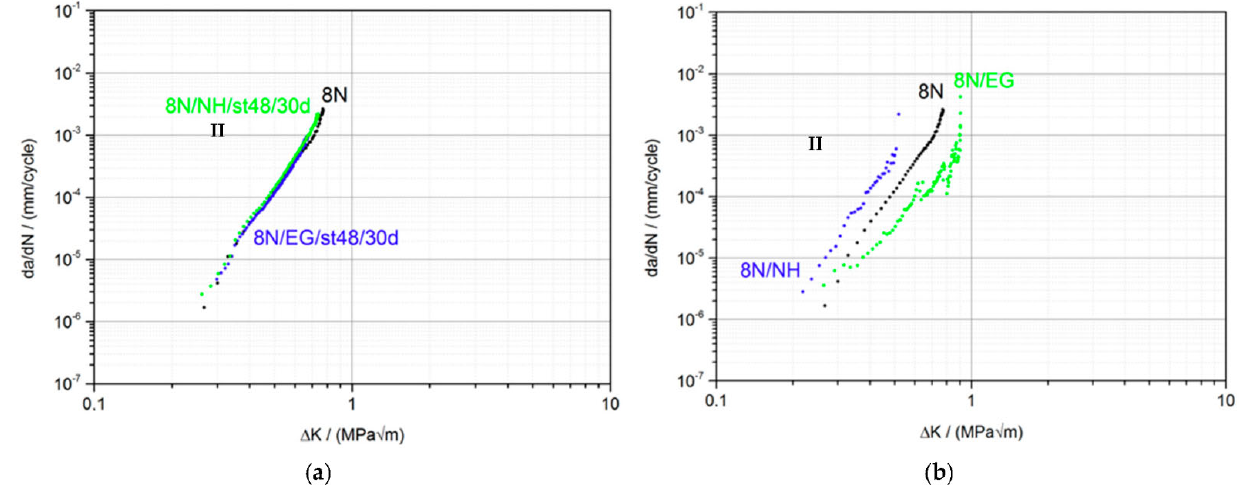
Figure 3. FCP ‐ behavior of PMMA prior to immersion ( a ) and in situ wetting ( b ) in EG and NH. Figure 3. FCP-behavior of PMMA prior to immersion ( a ) and in situ wetting ( b ) in EG and